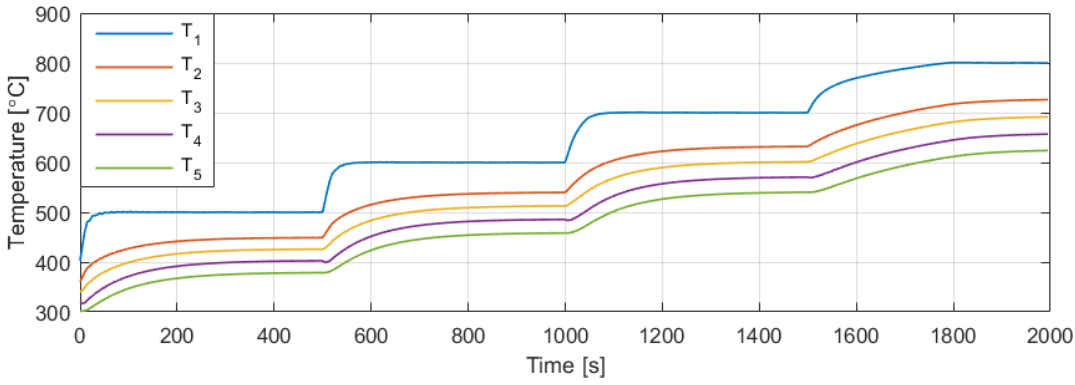
Figure 6. Temperature readings in thermocouples T 1 -T 5 for a start-up temperature ( T ref , start ) in the heater of 400°C, T ref,step = 100 °C step and end temperature ( T ref,end ) of 800 °C.